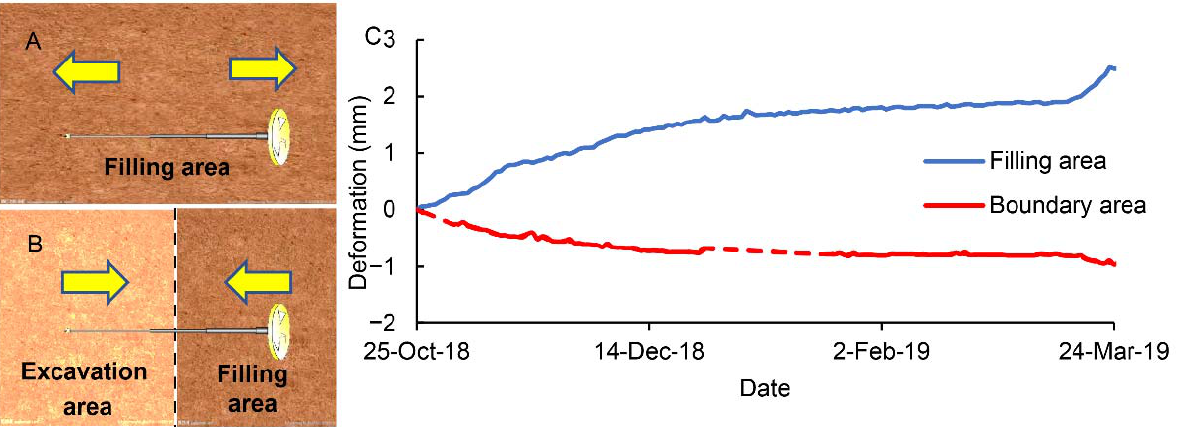
Figure 10. Horizontal displacement (( A ) is a schematic diagram of the deformation of the landfill area, ( B ) is a schematic diagram of the deformation at the boundary, and ( C ) is the deformation over time).